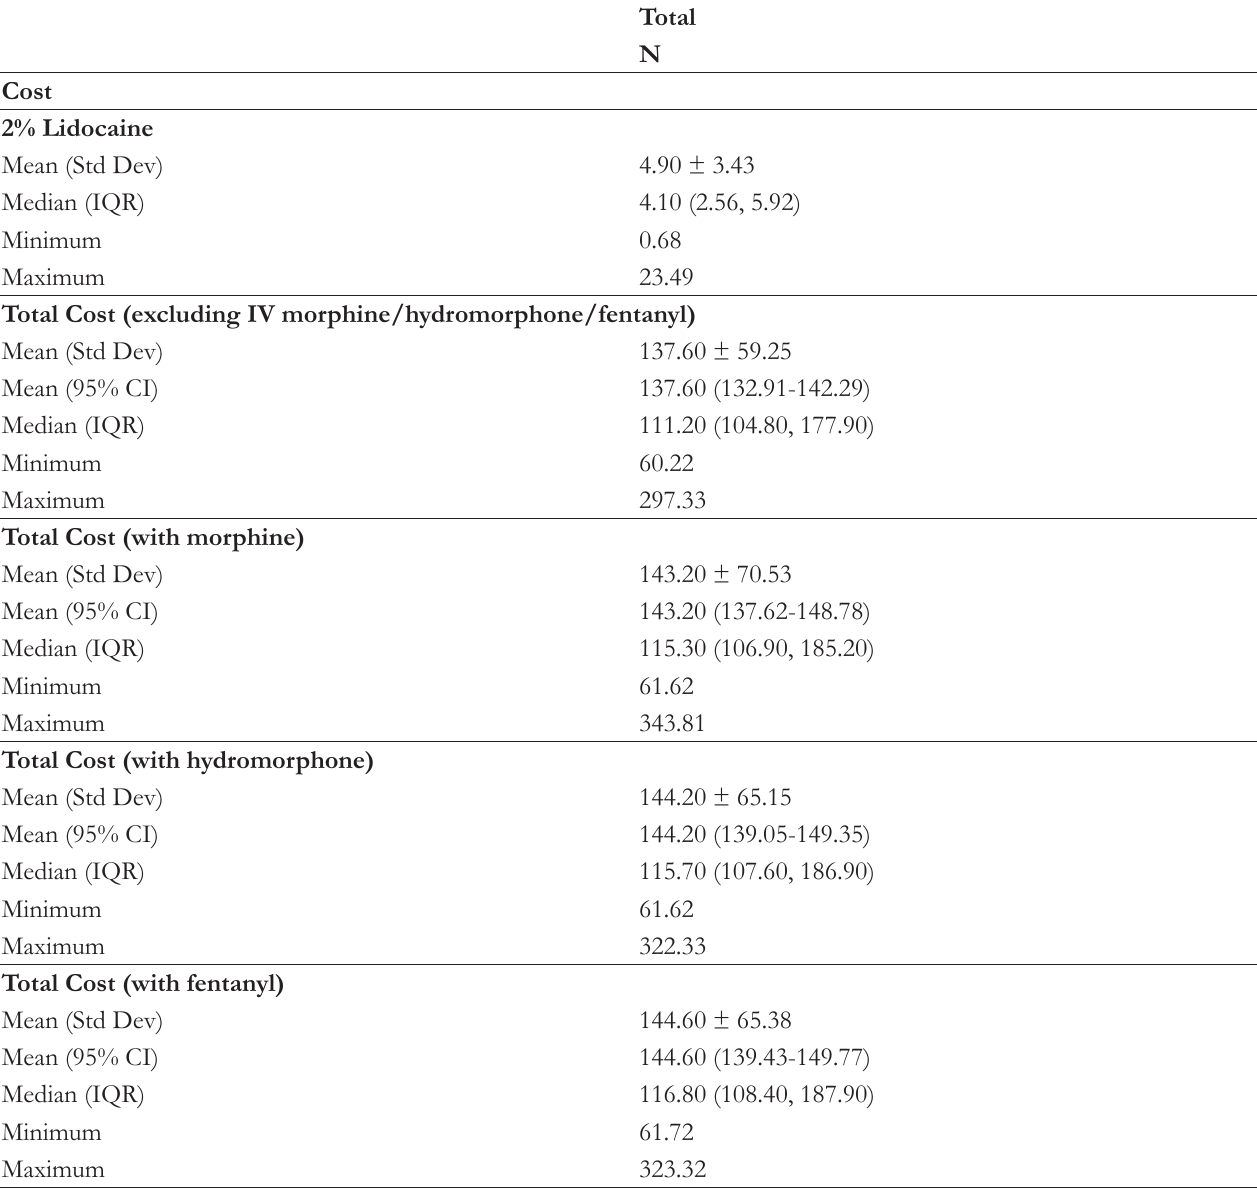
Table 4. Individual Costs (2016 USD)